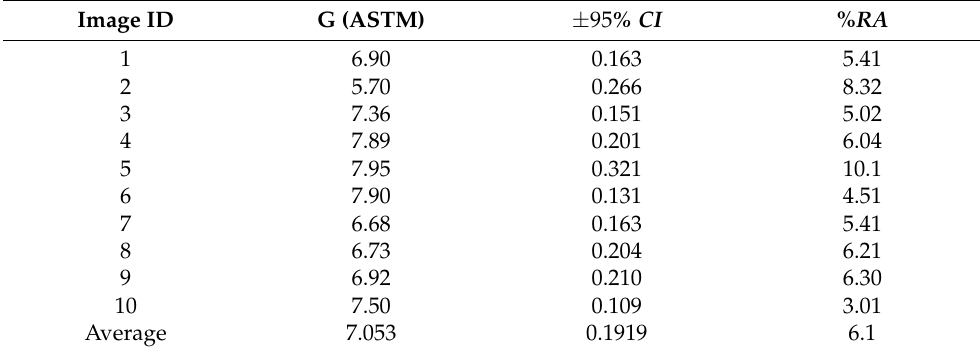
Table 6. Typical grain size level statistics in